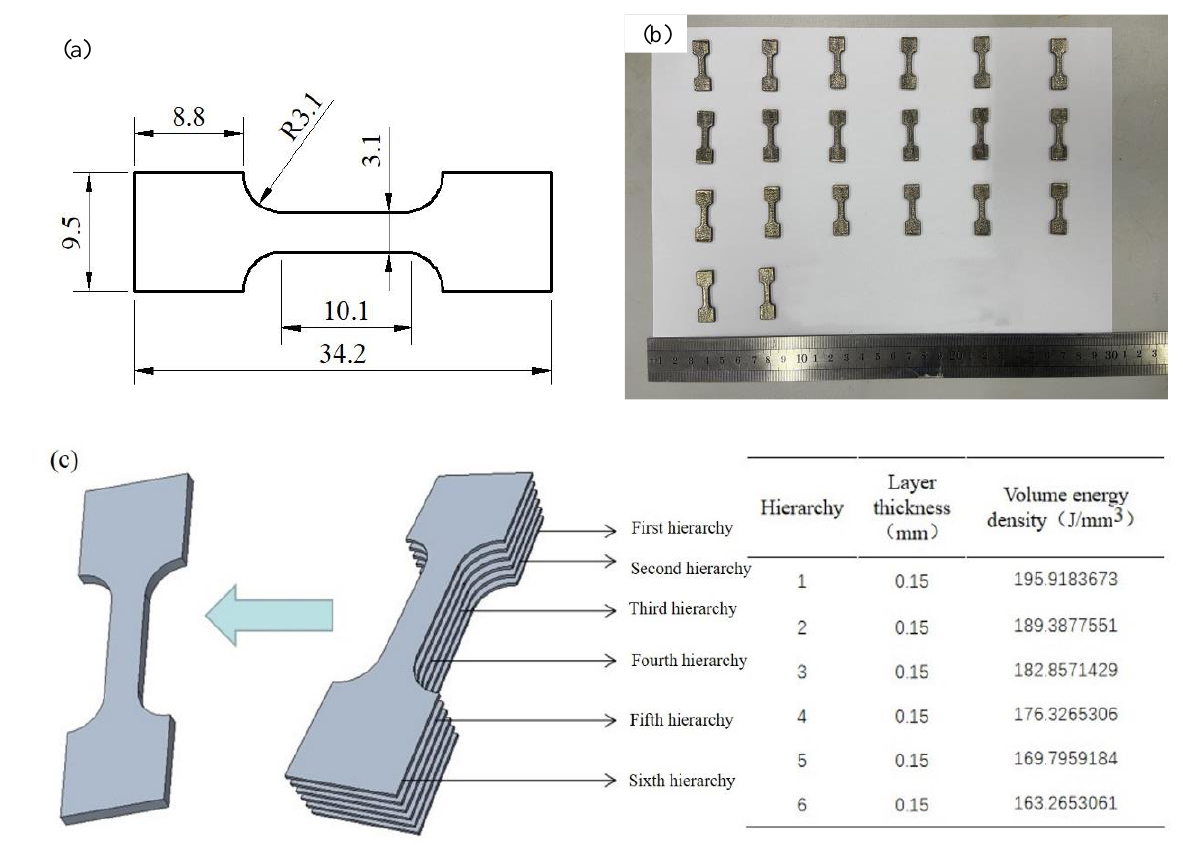
Figure 4. Size of tensile parts and distribution of physical density of six hierarchies of tensile parts. ( a ) Geometry of tensile parts; ( b ) Forming specimens; ( c ) Distribution of the physical density of six hierarchies of tensile parts.